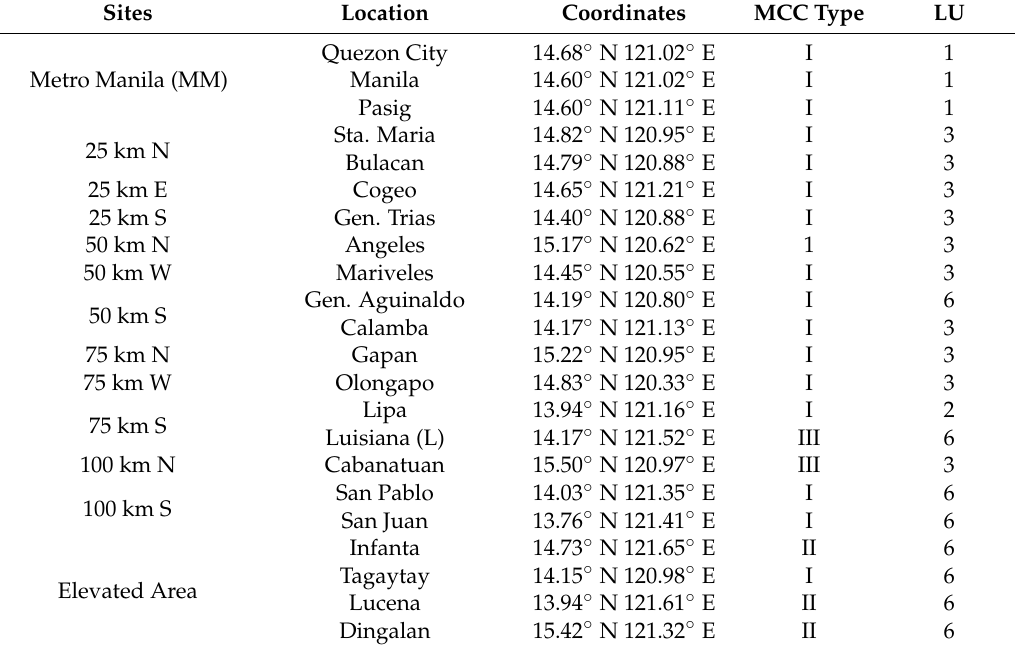
Table 2. Selected urban and rural areas with corresponding Modified Corona Classification (MCC) and land use (LU)